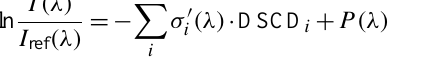
Fig. 4. Some of the weighting functions relative to the NO 2 slant column measurements of the 8 April 2008 in linear (left panel) and loga- rithmic (right panel) scale. Beside the altitudes of observations are indicated the telescope line-of-sight angles (0 ◦ is nadir, 90 ◦ horizontal).